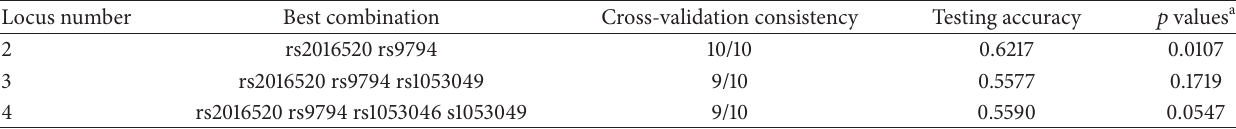
Table 4: Best gene-gene interaction models, as identified by GMDR.